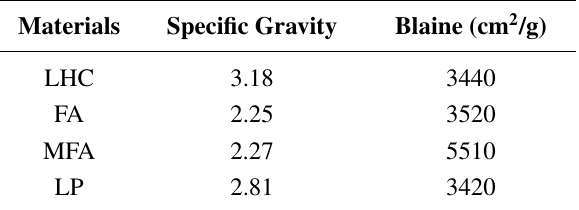
Table 2. Physical characteristics of raw materials.